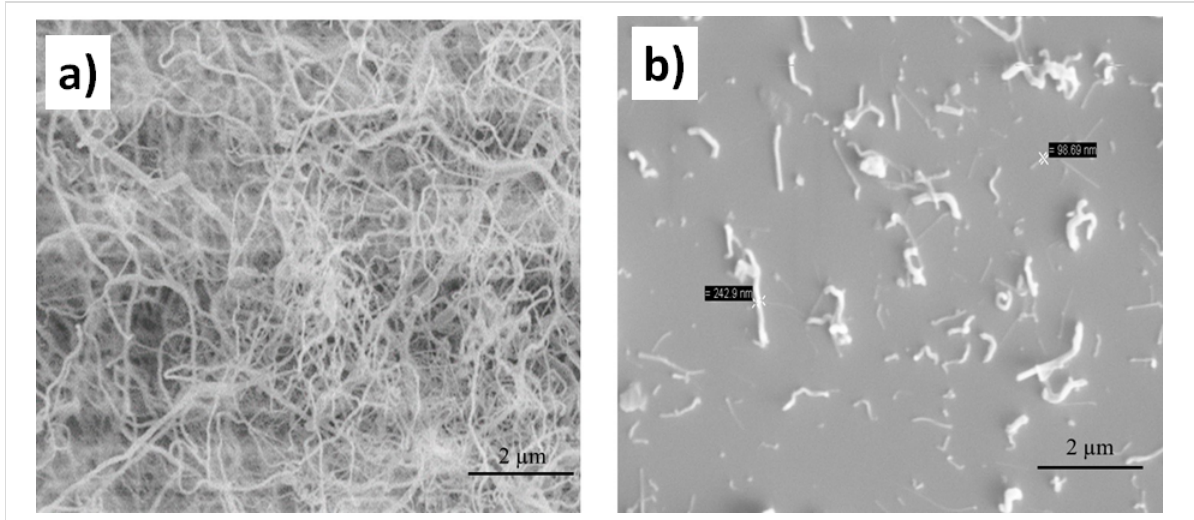
Figure 5: SEM image of pristine BNNTs (a) and P(AA- co -FA)-functionalized BNNTs (b) after dispersion in water.